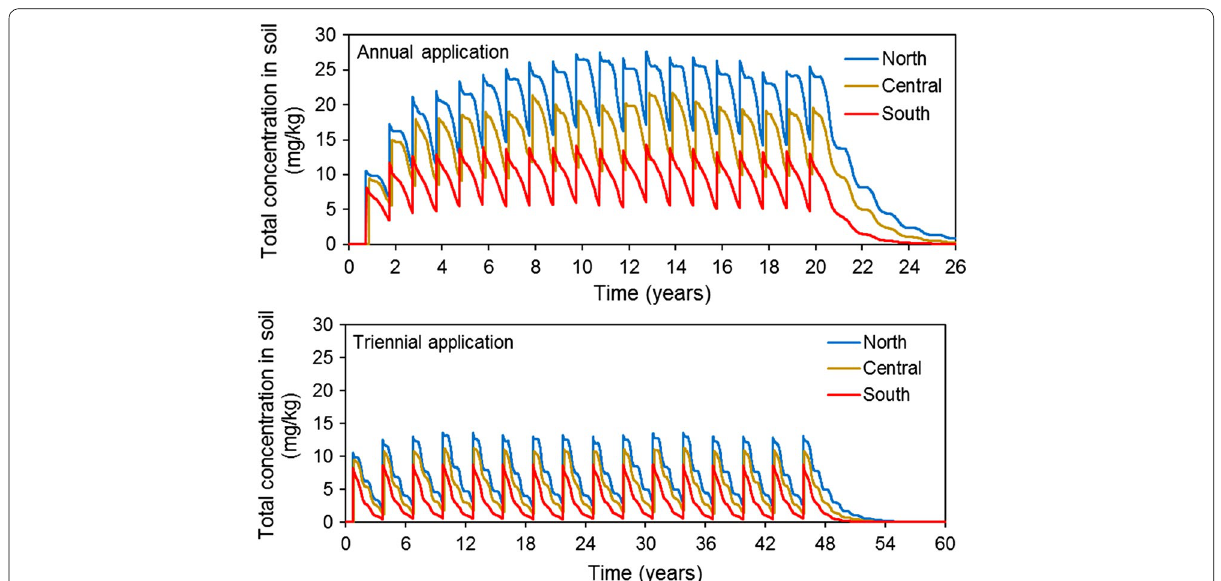
Regulatory Zones [18, 20] for annual ( top panel ) and triennial application ( bottom panel )